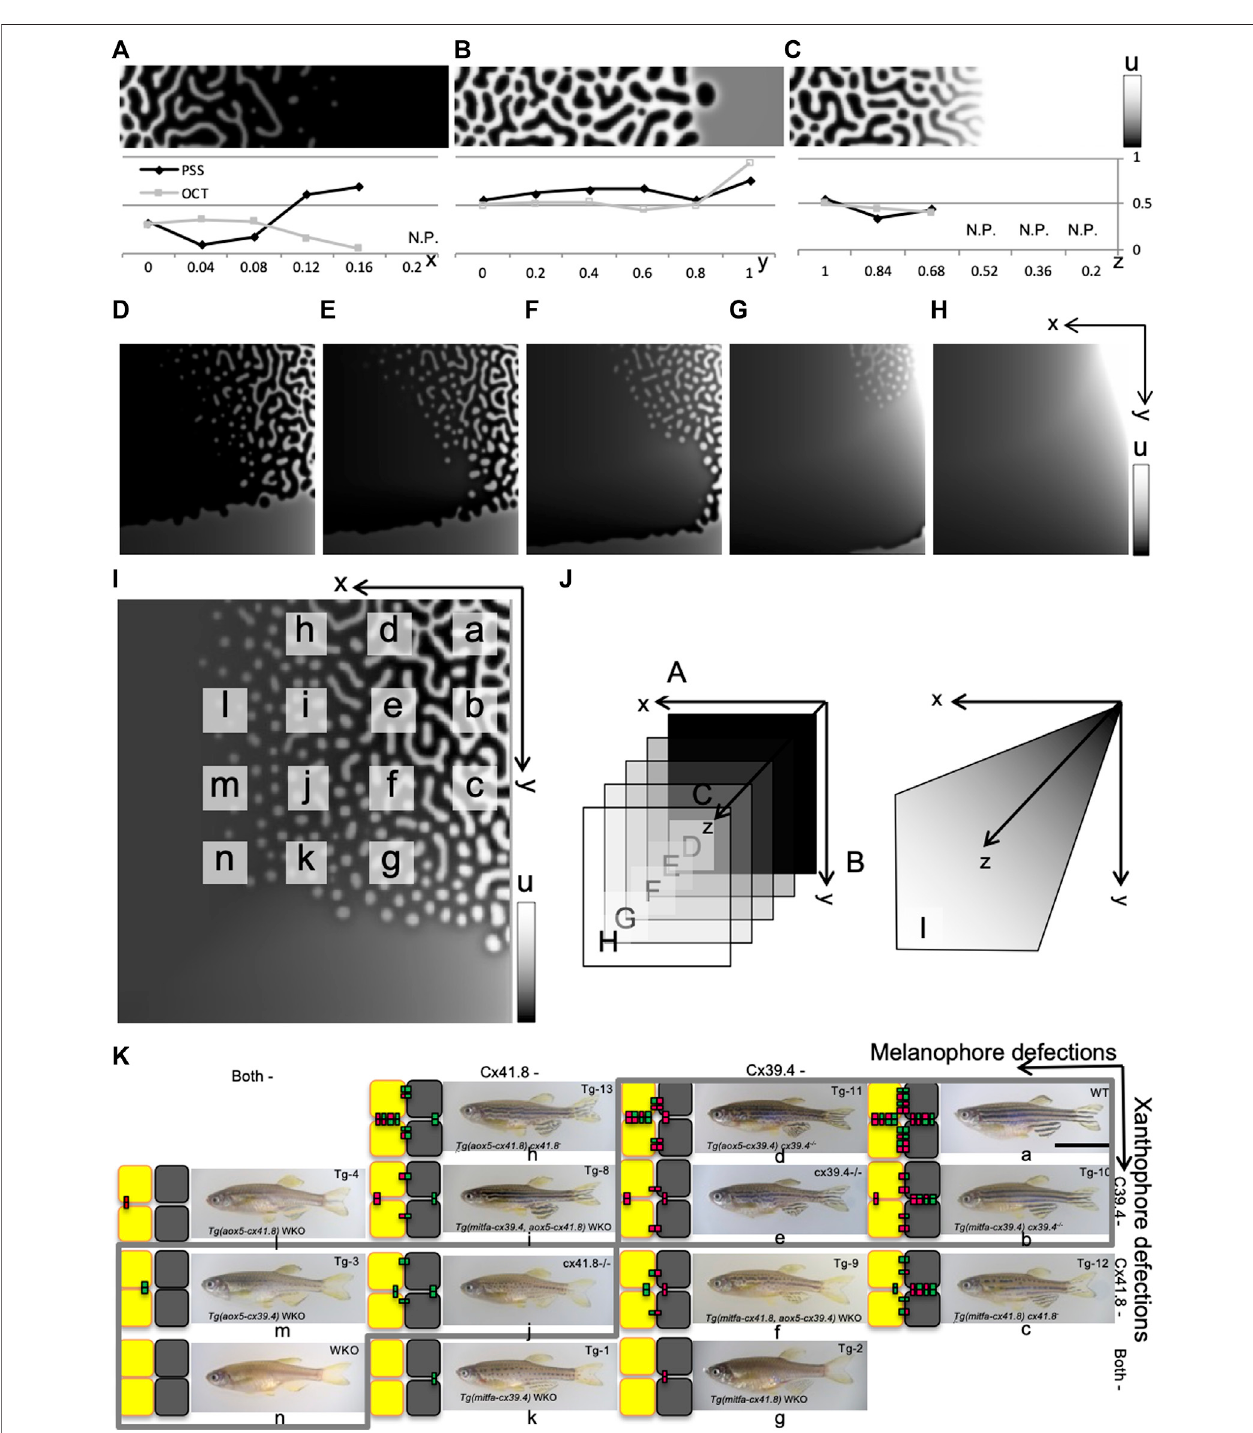
FIGURE 4 | Numerical results of gate effects and comparison with experiments. (A – I) Numerical results obtained from a model of linear reaction terms with limits. Patternshifts wereobserved when the effects ofgate defects onboth cellswerechanged.Defects ofgates on U and V cellsand between thecells become larger along the x − , y − , and z (or x , y ) − axes, respectively. (A – C) Eachdefectwas analyzedindependently withquanti fi cationofpatterns. (A) U defect, (B) V defect, and (C) short-range defects. PPS and OCT were obtained quantitatively. The short-range effects by gap junctions were eliminated from arbitral wild-type condition (D) 0.05 to (E) 0.04, (F) 0.03, (G) 0.02, and (H) 0.01. (I) Numerical result of linear terms with limits in which the short-range effects were spontaneously changed along the x − and y − axes with increasing u d anddecreasing v d .Eachsmallletterindicatesthecorresponding fi shwithconnexinconditions. (J) Schematicsofthisanalysesutilizingthepresentlinearmodel. U defect, (B) V defect, and (C) short-range defects were changed along with the axes in each panel as shown in the fi gures. (K) Pigmentation pattern on connexin- manipulated fi sh slightly changed from [8], with permission to use the fi gures from Dr. M. Watanabe. Gray fl amed fi sh had correspondence to numerical results.